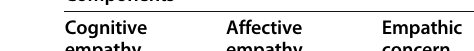
Components Cognitive Affective empathy